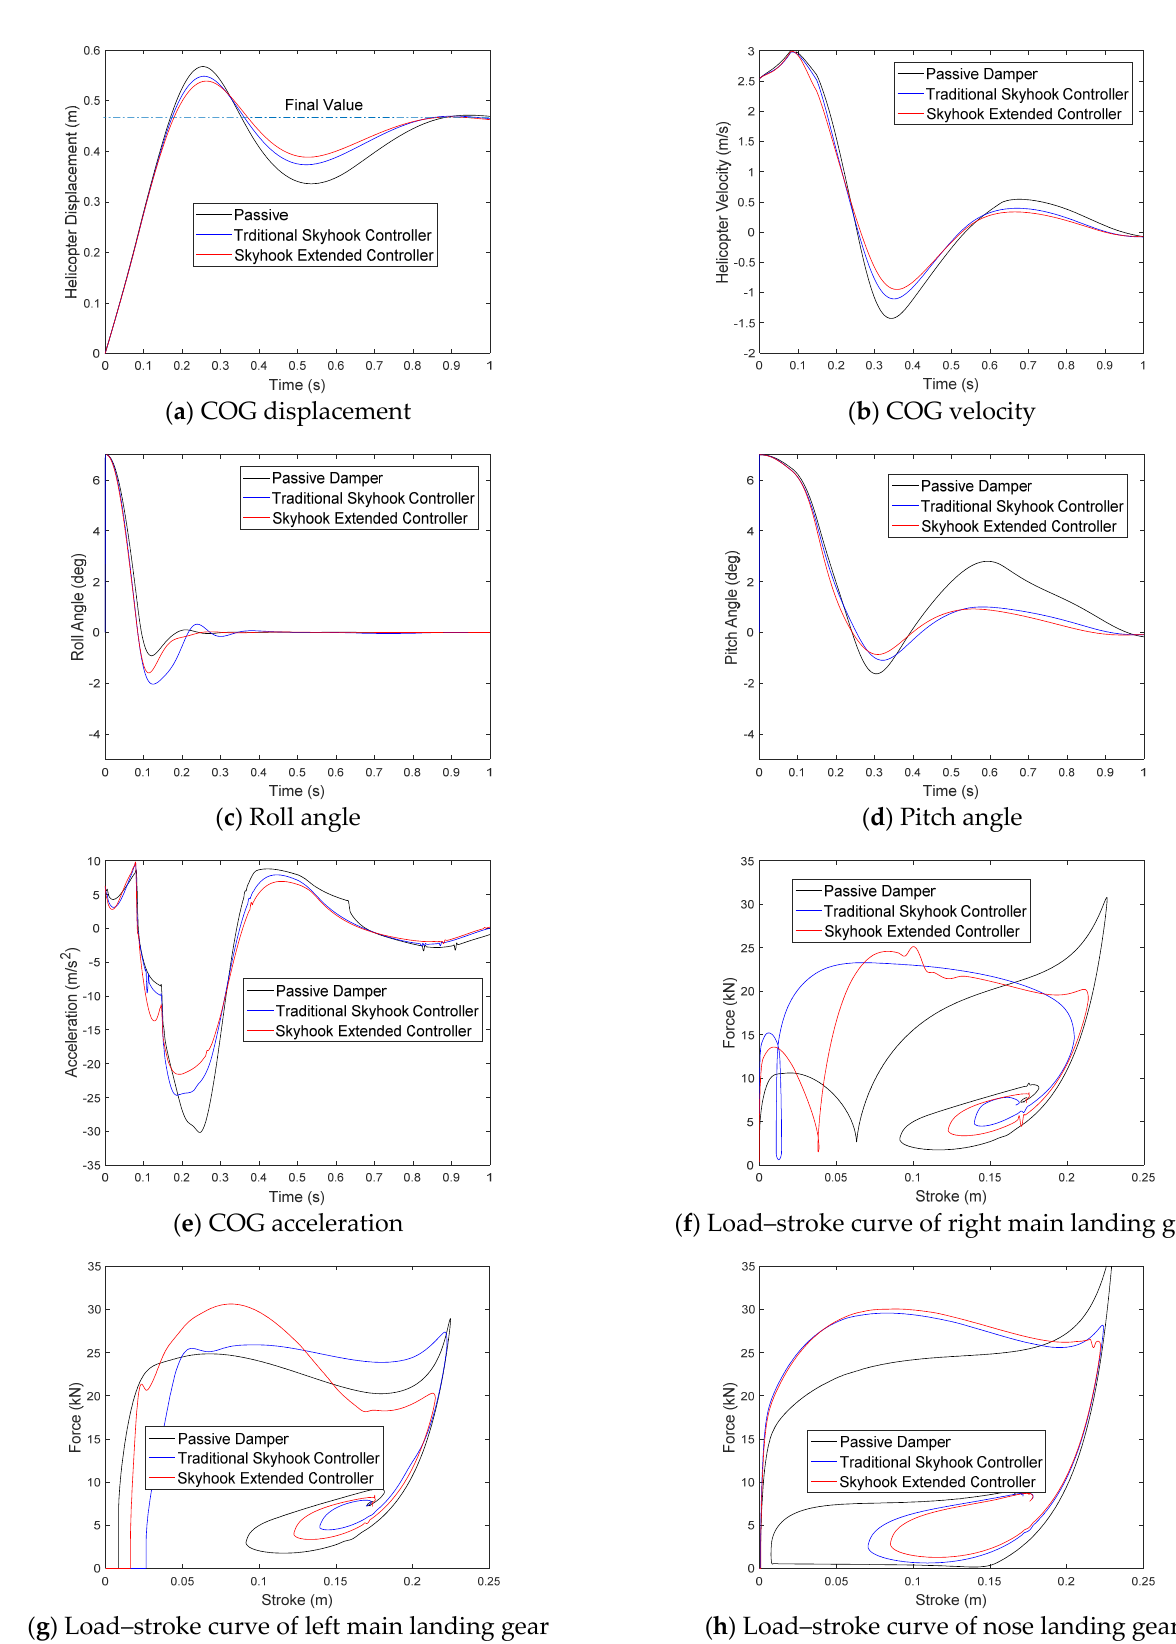
Figure 14. Comparative simulation results of the passive damper, traditional skyhook controller, and skyhook extended controller at θ = 7 ° and Φ = 7 ° .